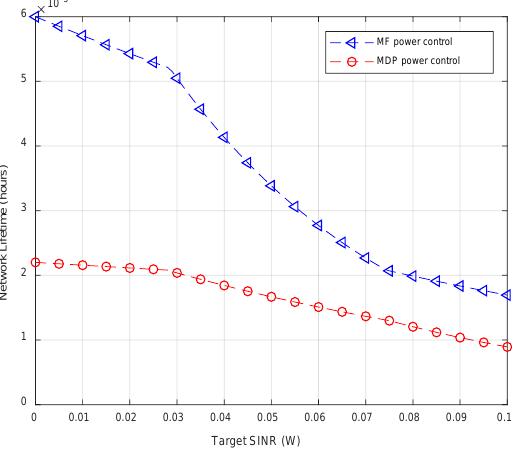
Figure 10. Target SINR impact on MTCDs network.